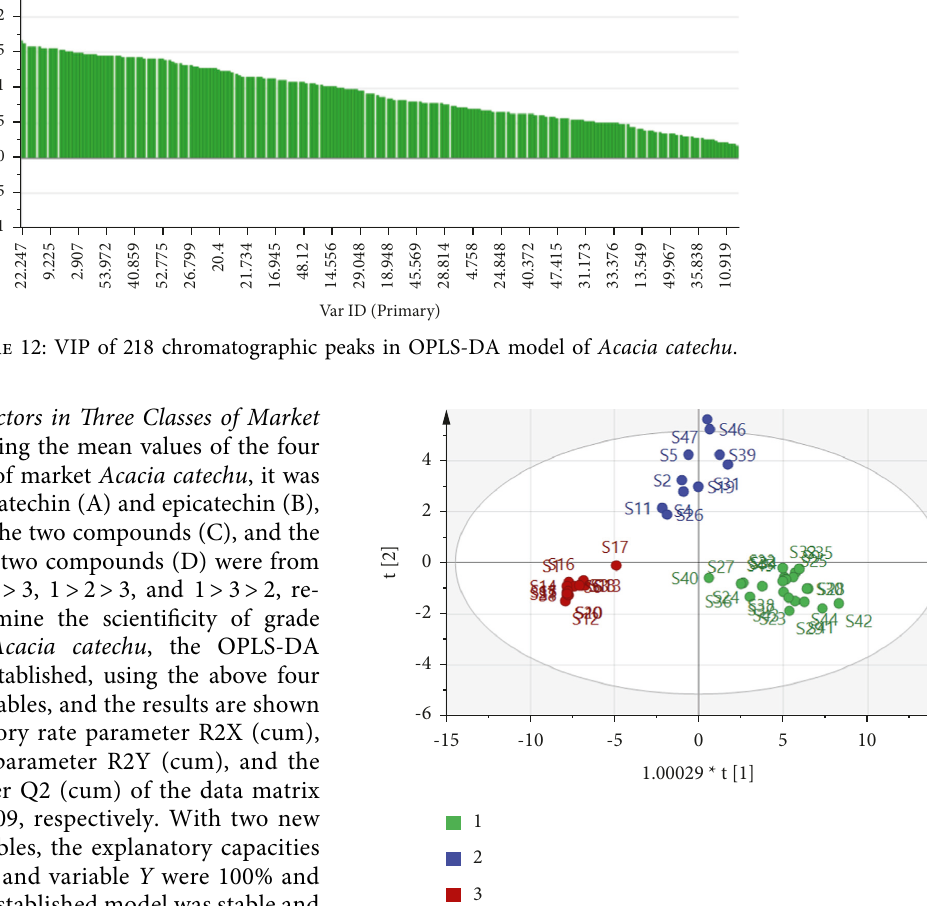
Figure 13: OPLS-DA score plot of 46 batches of Acacia catechu .